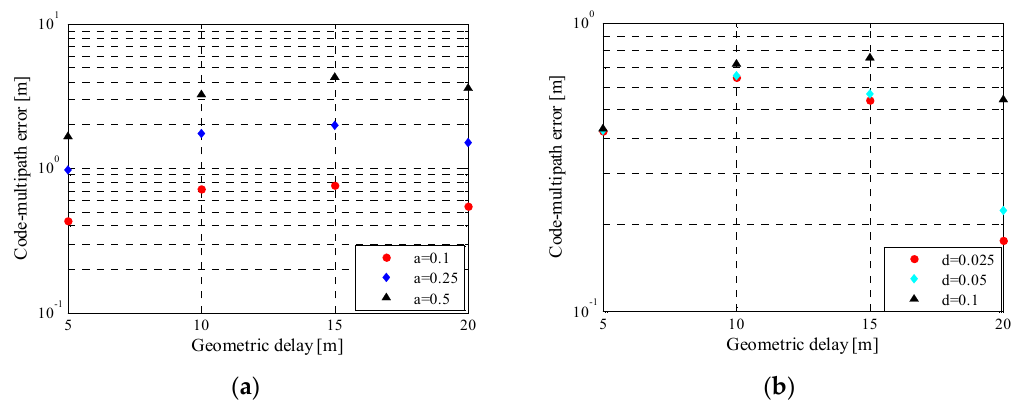
Figure 12. Multipath error( a ) and average multipath error( b ) for NSCCs with different code rates and its reference baseline.